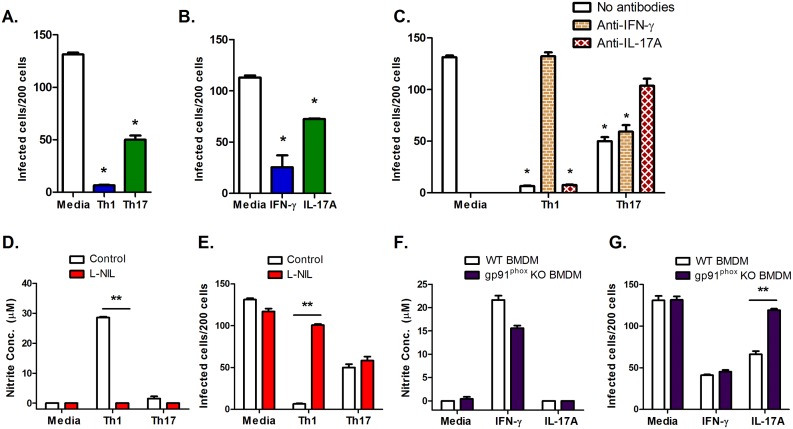
Th17 cells can inhibit T. cruzi intracellular growth in macrophages in vitro by inducing NADPH oxidase via IL-17A.PEMs were infected with trypomastigotes for 3 hours (MOI = 5). T. cruzi-specific TCR Tg Th1 or Th17 cells were then added to macrophages 1:25. Two days later, slides were Giemsa stained and intracellular parasites counted microscopically. Th1 and Th17 cells (A), as well as IFN-γ or IL-17A alone (B) were able to decrease the number of infected macrophages. *p<0.001 compared to medium alone by two-tailed Student t test. (C) Neutralizing antibodies directed against IFN- γ or IL-17A were able to abolish the direct protection provided by Th1 and Th17 cells, respectively. (D-E) The effects of the iNOS inhibitor L-NIL on Th1- and Th17-induced NO production and T. cruzi protection are shown. **p<0.001 by two-tailed Student t test. (F+G) BMDMs from wild type (WT) and gp91phox KO mice were infected with T. cruzi for 3 hours (MOI = 10), then cytokines IFN-γ and IL-17A were added. Two days later, NO was measured (F) and intracellular parasites were enumerated (G). **p<0.001 by two-tailed Student t test. These results were reproduced in multiple experiments.